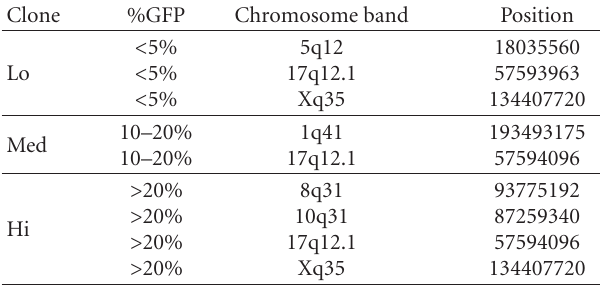
Table 3: Correlation of GFP expression and integration site for φ C31 Integrase. Three clones were selected based on the expression level of GFP (high, medium, or low). Plasmid rescue was carried out to determine if the expression level correlated with integrant number or genomic